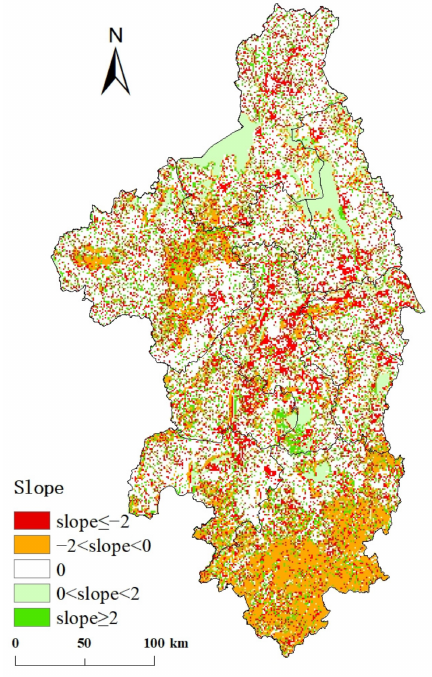
Figure 5. ESV trends from 2000 to